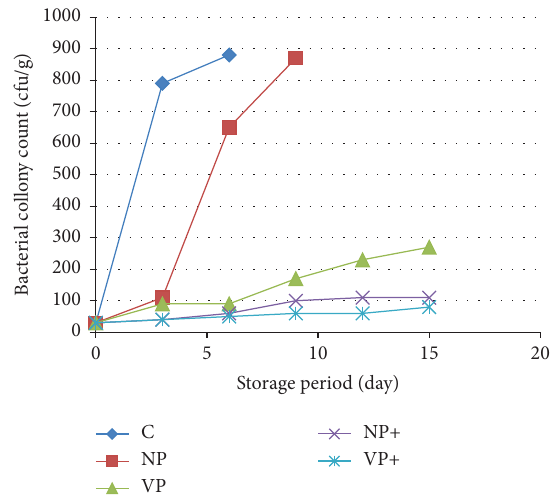
Figure 1: Colony forming units of bacteria/g of injera with re- spective treatments at diferent storage intervals. For “C” and “NP” treatments, the experiment was terminated at 6 th and 9 th day of storage, respectively, since the samples were